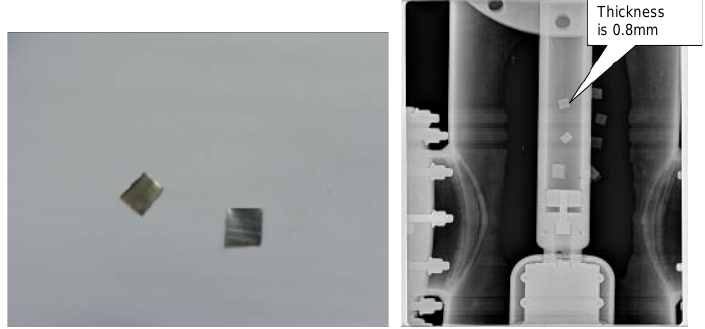
Figure 9. Metallic flaky particle.